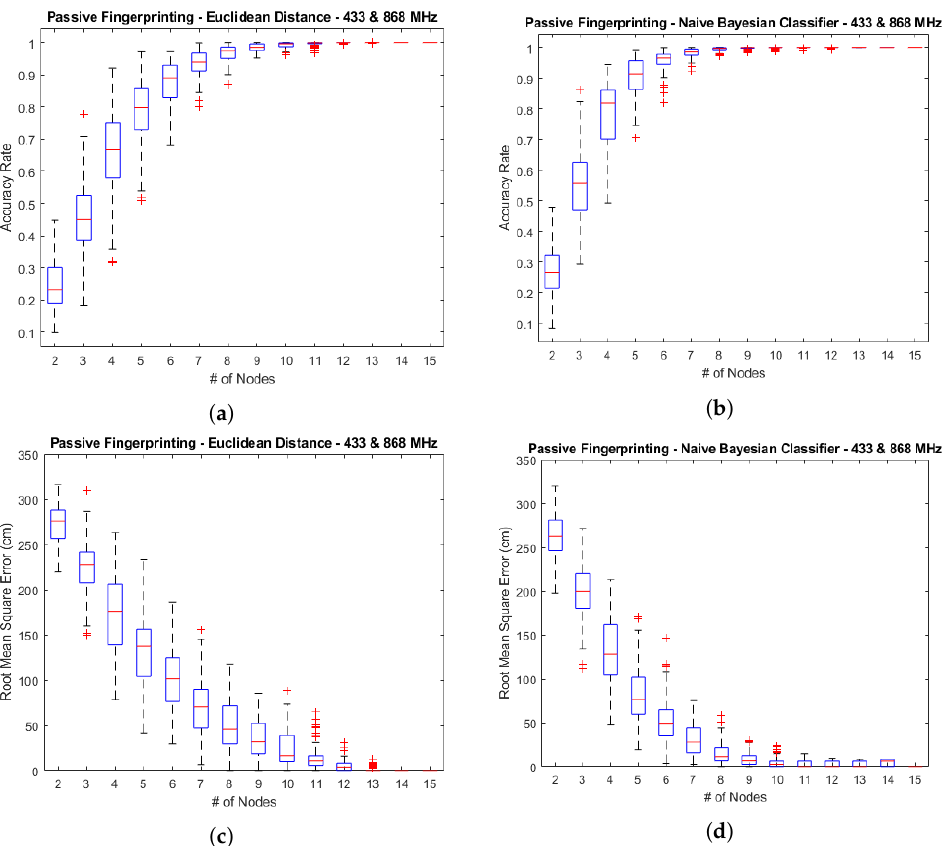
Figure 7. Box plots of the accuracy rates and root mean square distance errors based on a combination of 433 MHz and 868 MHz data. ( a ) and ( b ) show the accuracy rates for respectively the Euclidean distance-based and naive Bayesian classifier-based methods, while ( c ) and ( d ) show the root mean square distance errors for both